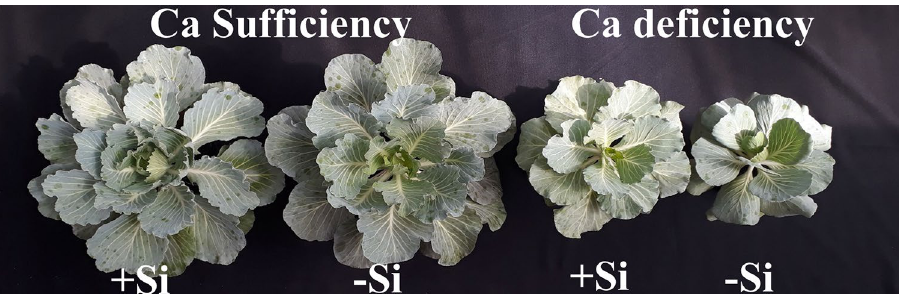
Figure 5. Cabbage plants grown under Ca sufficiency and Ca deficiency, without (− Si) and with (+ Si) added